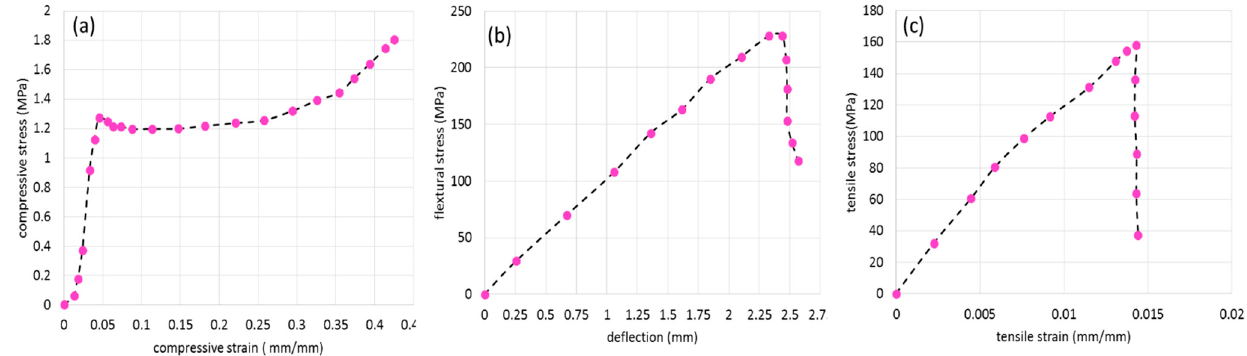
Figure 3. ( a ) The compressive stress–deflection response of polyurethane foam core, ( b ) the flexure stress–flexure deflection